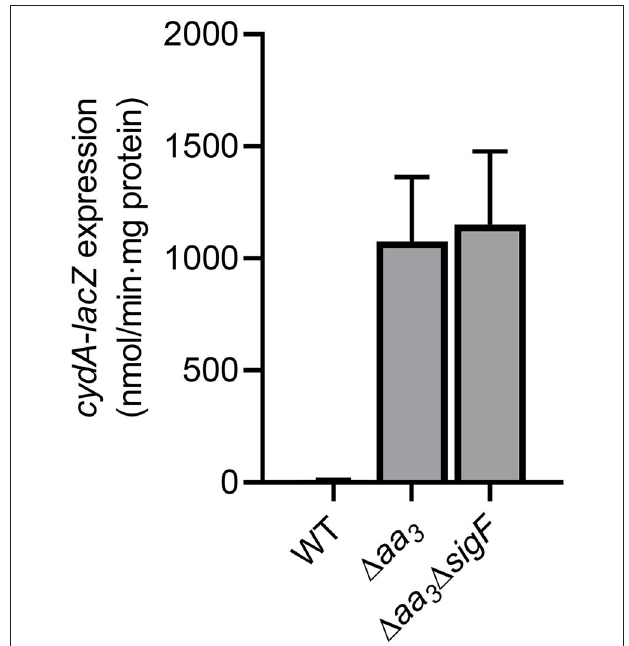
FIGURE 1 | Expression of the cydAB operon in the WT, 1 aa 3 , and 1 aa 3 1 sigF mutant strains of M. smegmatis . The WT, 1 aa 3 , and 1 aa 3 1 sigF mutant strains of M. smegmatis harboring the cydA::lacZ translational fusion plasmid pNCIIcydA were grown aerobically to an OD 600 of 0.45–0.5 in 7H9-glucose medium. Cell crude extracts were used to determined β -galactosidase activity. All values provided are the averages of the results from three biological replicates. The error bars indicate the standard deviations.